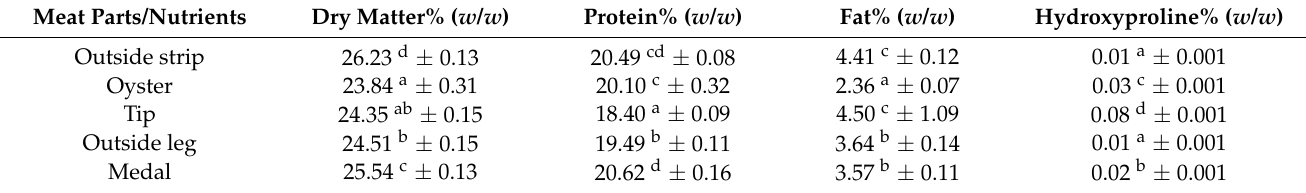
Table 4. Nutritive composition of the five examined valuable meat parts ( n =